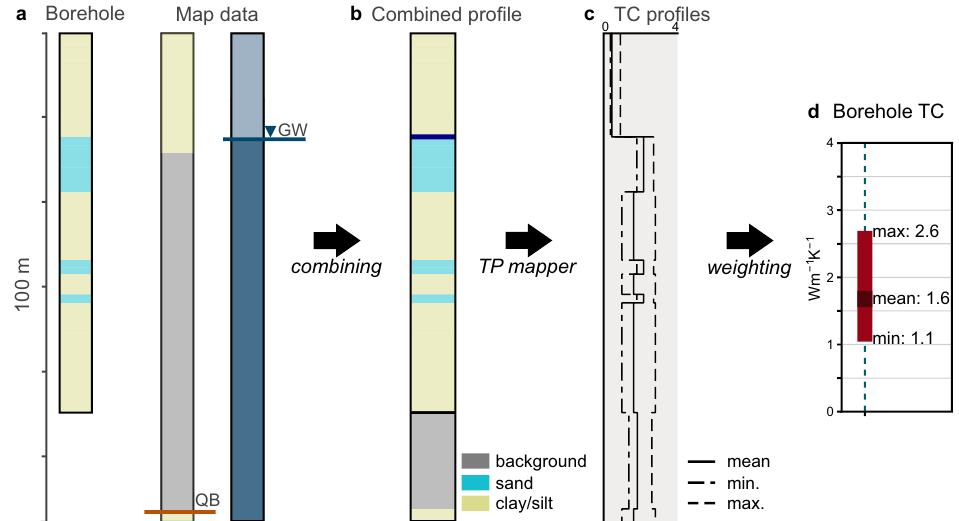
Figure 4. Estimation of the mean thermal conductivity of a borehole. Abbreviations: QB: Quaternary base, GW: groundwater